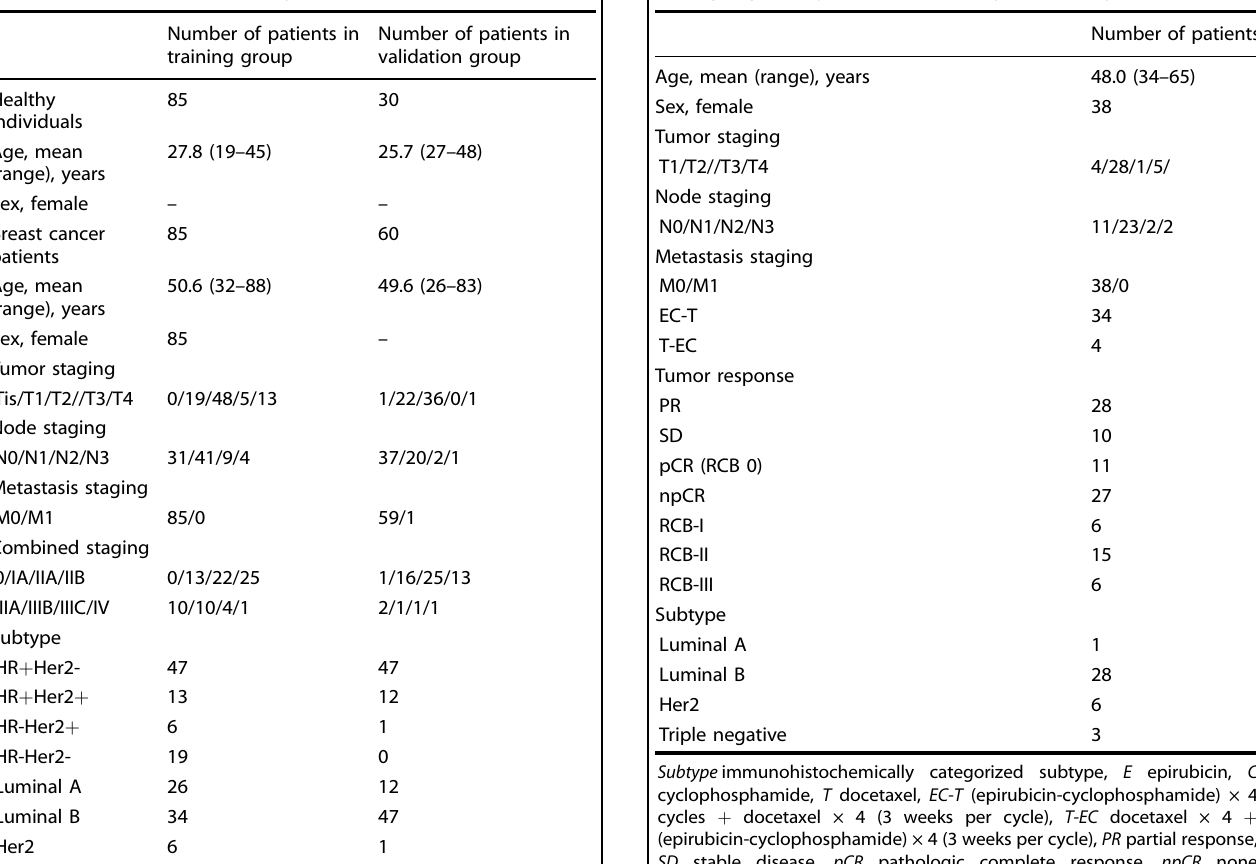
Table 1. Clinical characteristics of the 115 healthy individuals and 145 breast cancer patients in the study.